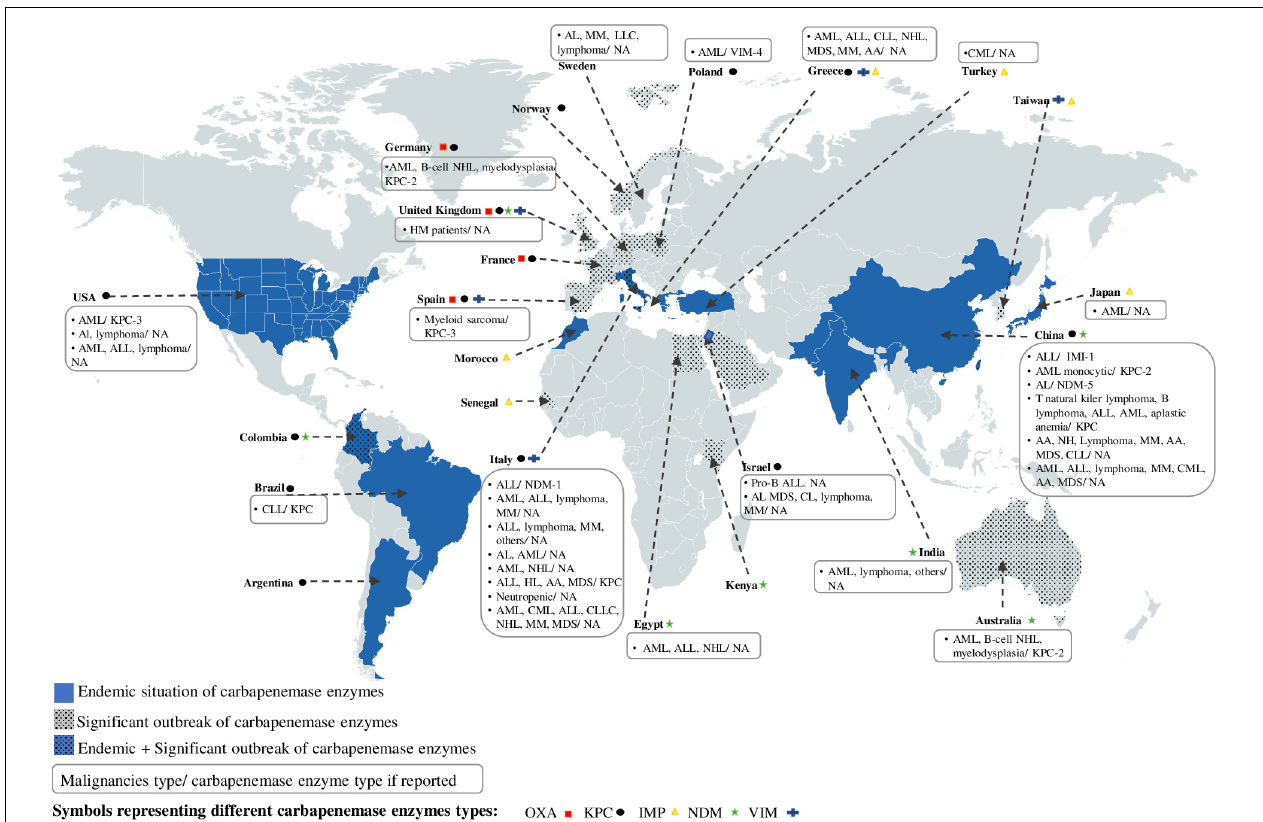
FIGURE 1 | Worldwide distribution of carbapenemase enzymes depending on their regional endemicity or significant outbreak situation and geolocation of studies reporting the occurrence of CR bacteria isolated in HM patients. AA, aplastic anemia; AL, acute leukemia; ALL, acute lymphoid leukemia; AML, acute myeloid leukemia; CLL, chronic lymphocytic leukemia; CML, Chronic myeloid leukemia; HL, Hodgkin’s lymphoma; HM, hematologic malignancy; MDS, myelodysplatic syndrome; MM, myelome multiple; NHL, Non-Hodgkin’s